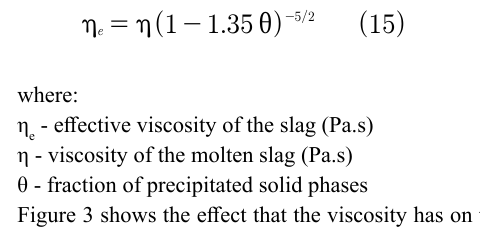
Figure 4: Influence of the %CaO/%SiO acidic slag and b) basic